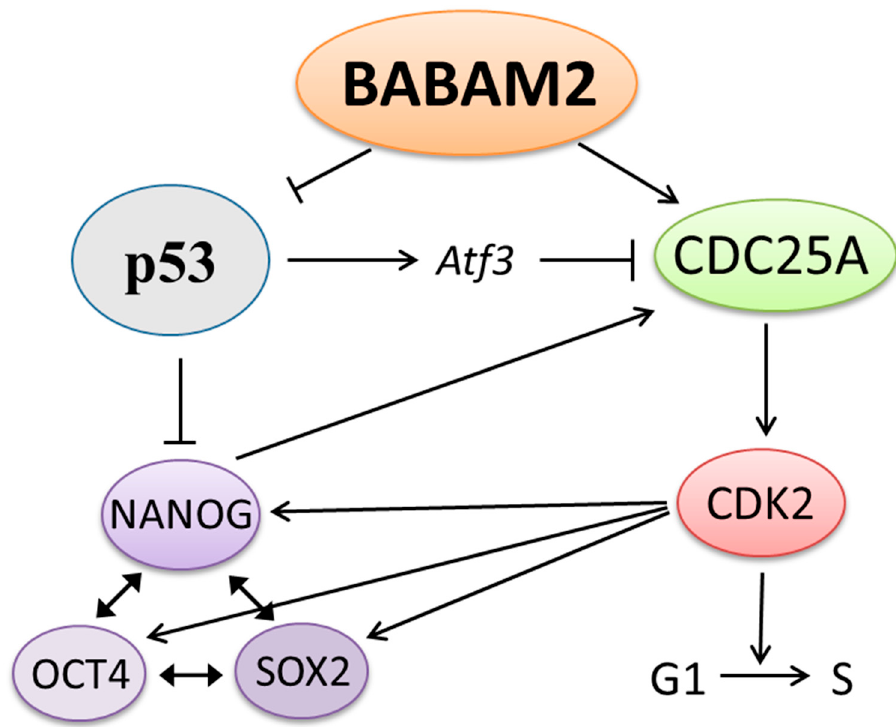
Figure 7. Schematic diagram showing BABAM2’s involvement in the regulation of cell cycle progression and pluripotency in mESCs following DNA damage. BABAM2 stabilizes CDC25A by promoting the deubiquitination of CDC25A. CDC25A then activates CDK2 and promotes G1 / S cell cycle progression. In addition, CDK2 stabilizes NANOG, OCT4, and SOX2, which are key regulators of the pluripotency state. BABAM2 can inhibit p53 by promoting p53 ubiquitination. p53 can inhibit cell cycle progression by inhibiting CDC25A through the activation of Atf3. In addition, p53 can inhibit NANOG expression that plays an important role in regulating the core circuits of pluripotency. NANOG has also been reported to promote CDC25A expression.